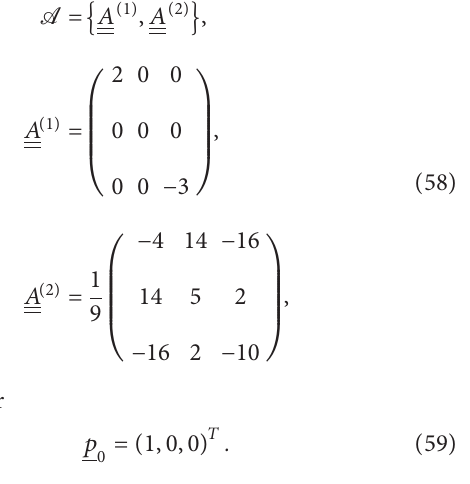
for Λ and p ; (b) isolines of the quadratic forms x T Λ x and x T B 2 1